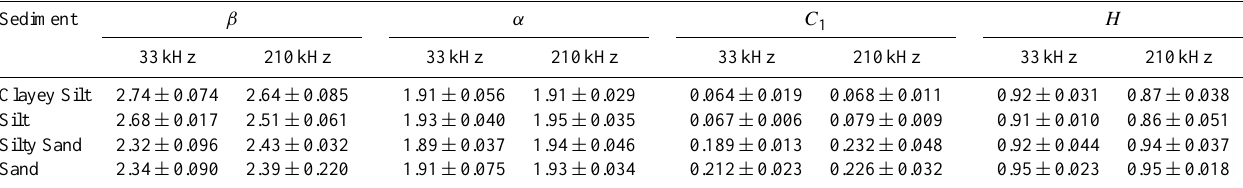
Table 1. Summary of universal multifractal parameters.